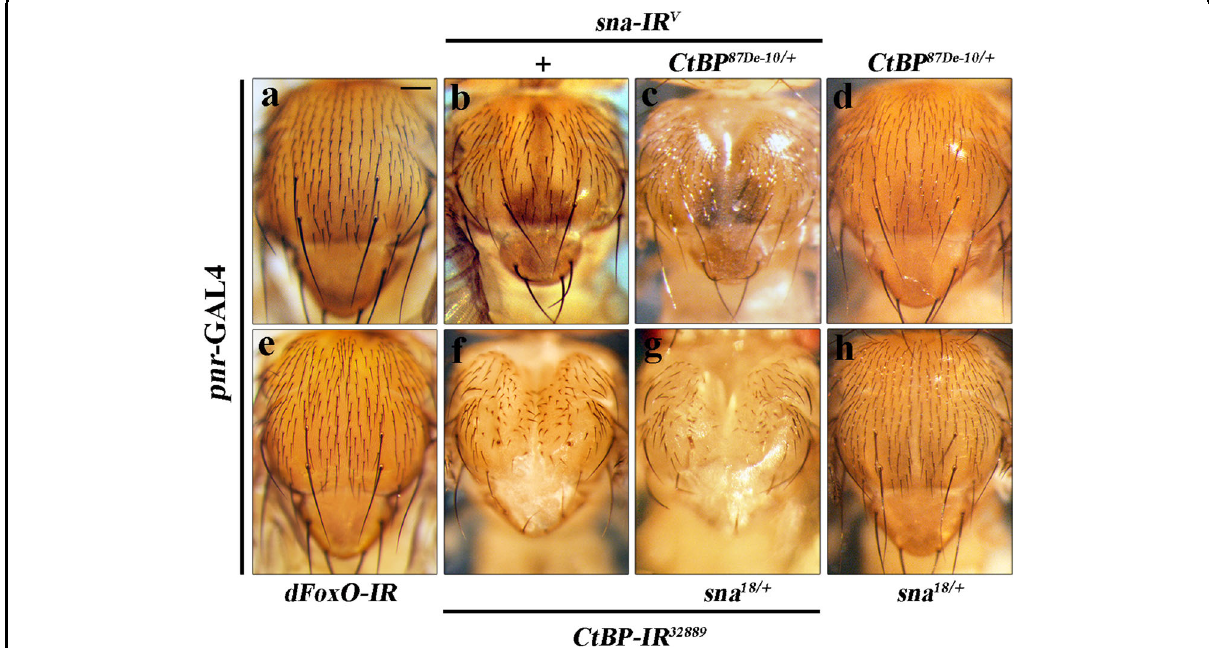
Fig. 6 Sna and CtBP participate in thorax closure during development. Light micrographs of Drosophila adult thoraxes are shown. Compared with the control ( a ), depletion of sna ( b ) or CtBP ( f ) induced thorax cleft in development. Mutating one copy of endogenous CtBP ( d ) or sna ( h ) produced no obvious phenotype, but synergistically aggravated the pnr > sna-IR ( c ) or pnr > CtBP-IR - ( g ) triggered thorax closure defects, respectively. Knockdown of dFoxO showed no obvious defects, which was used as a negative control ( e ). See the electronic supplementary material for detailed genotypes. Scale bar: 100 µm ( a – h